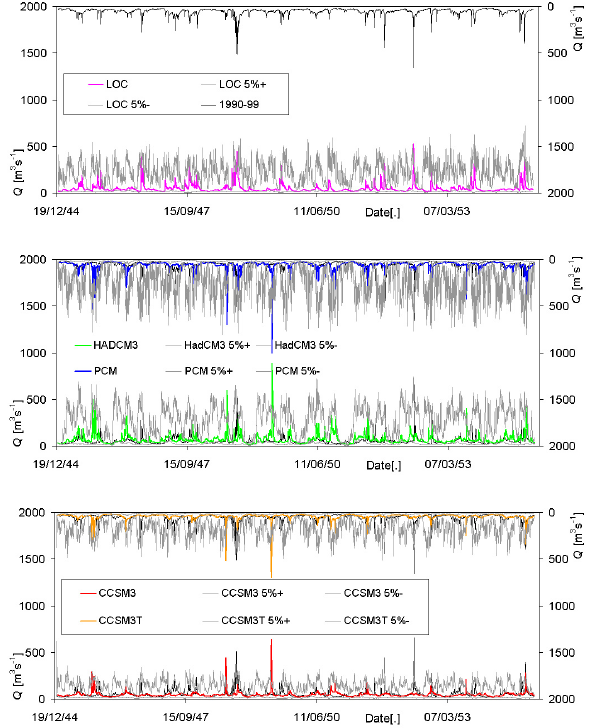
Fig. 5. Oglio at Sarnico. Scenario simulations, period 2045–2054. Daily flow discharges. Reference scenarios are reported together with confidence bounds from ensemble simulations ( α =5%). Ob- served discharges (1990–1999) reported, black line. (a) LOC. (b) HadCM3, PCM. (c) CCSM3, CCSM3T.